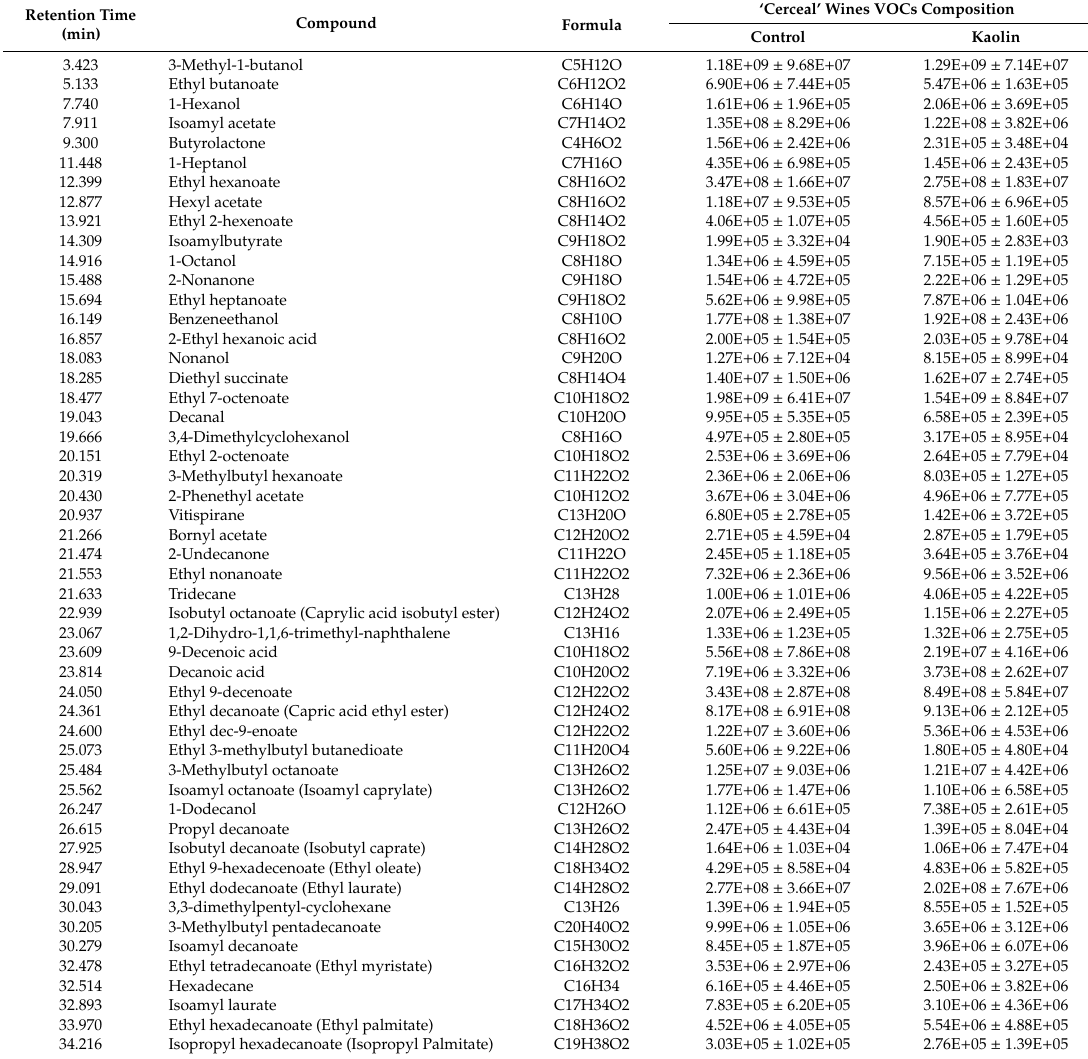
Table 8. Kaolin e ff ect on volatile composition (VOCs) of ‘Cerceal’ cv. wines determined by HS-SPME / GC-MS. Values are presented as mean area ±